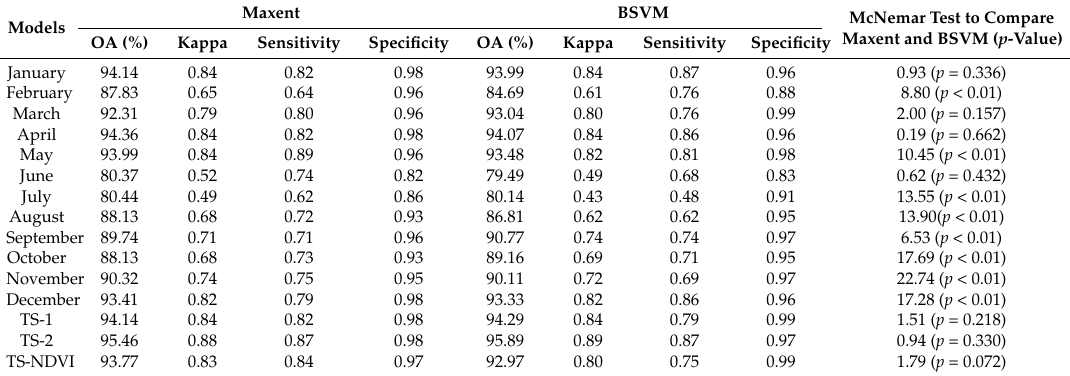
Table 3. Overall Accuracy (OA), kappa, sensitivity, specificity and the McNemar test results (| X | and p -value) for Maxent and BSVM methods. These accuracy indices of the proposed OCC methods under the 15 schemes of Setups 1–3 were calculated by the validation dataset.